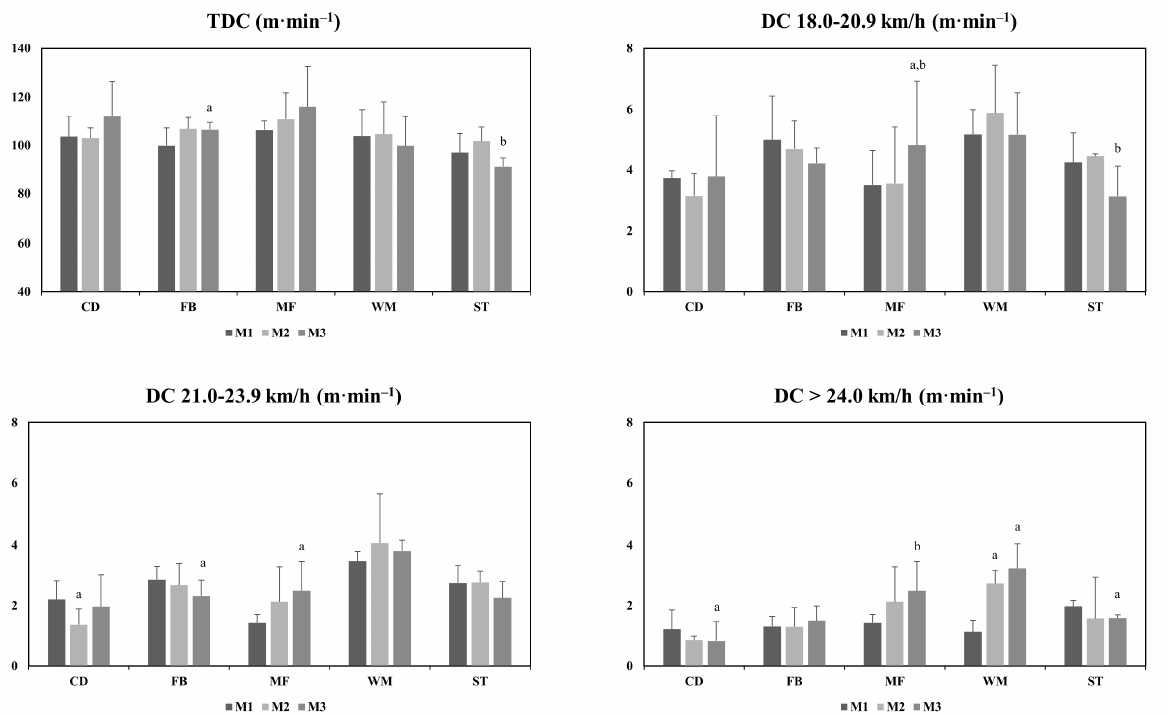
Figure 2. Comparison of distances covered at different speed thresholds during the three matches in a congested fixture. TDC = Total distance covered; CD = Central Defenders; FB = Fullbacks; MF = Midfielders; WM = Wide Midfielders; ST = Strikers; a = significant difference with M1; b = significant difference with M2.